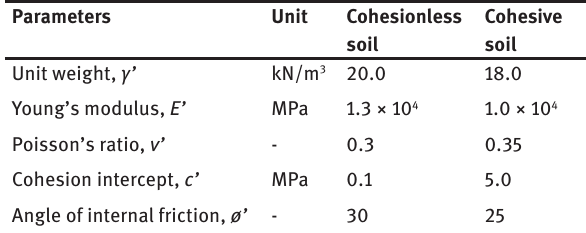
Table 2: Soil parameters for analysis of pile